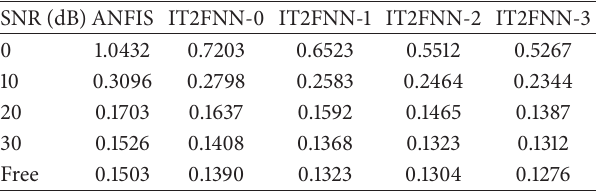
Table 2: Resulting RMSE (CHK) values in ANFIS and IT2FNN for non-linearity identification in Experiment 2 with 10-fold cross- validation.